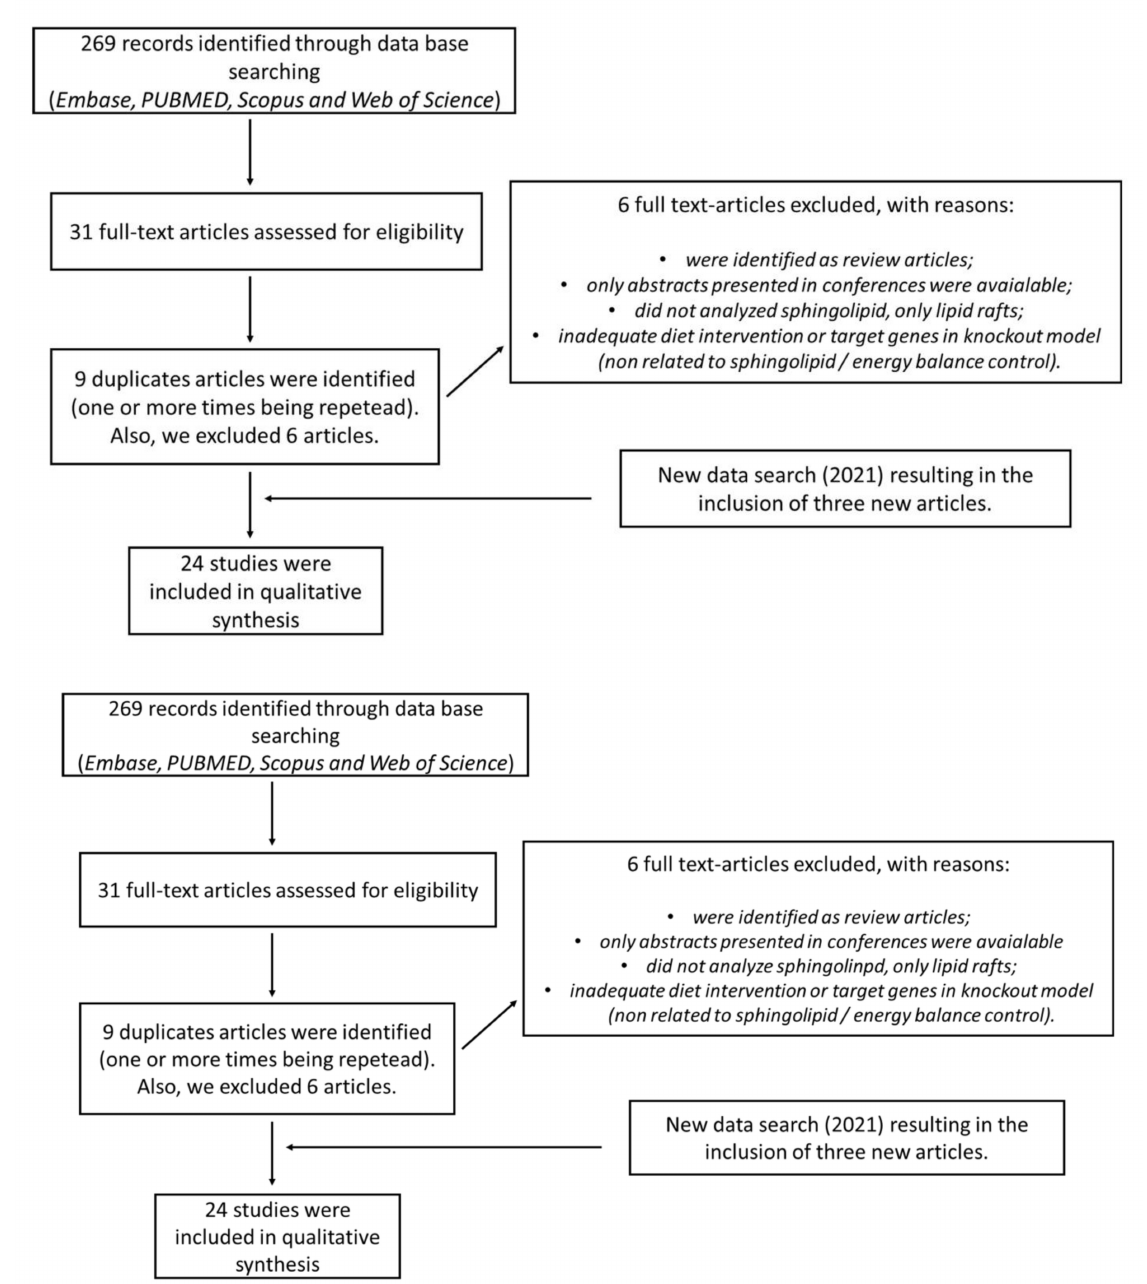
Figure 4. Flowchart of study selection process applied in this